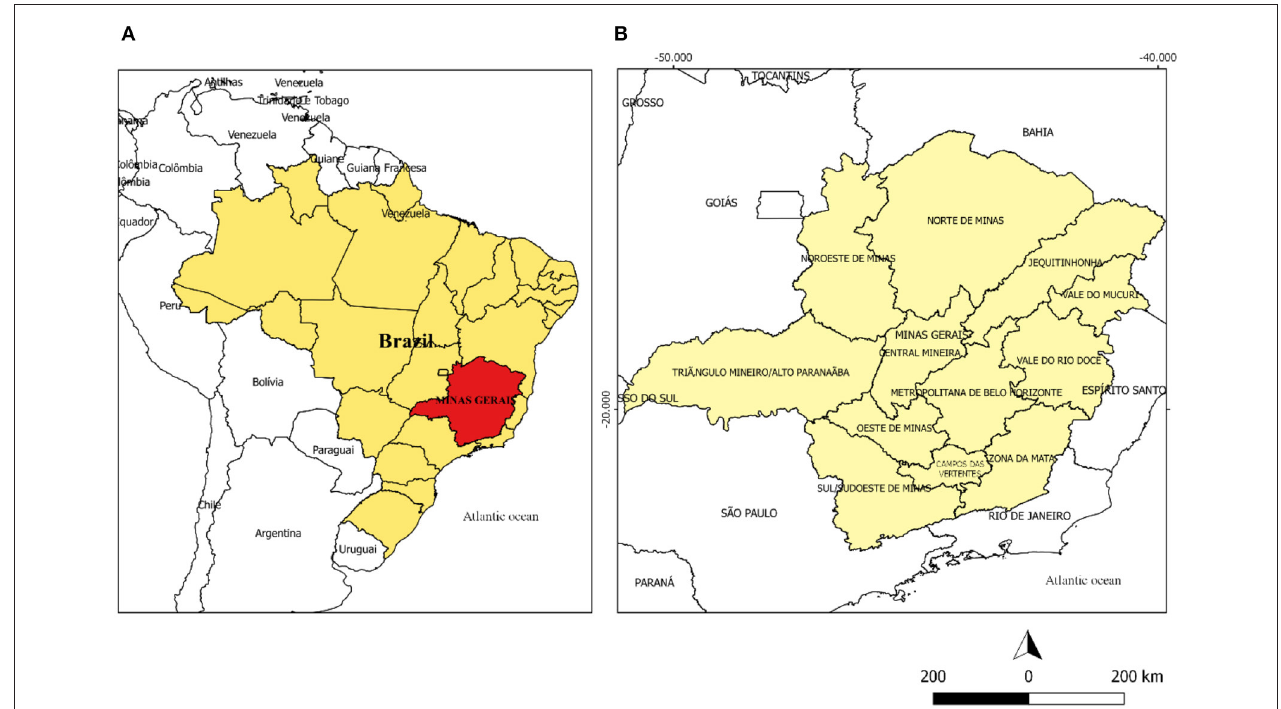
FIGURE 1 | (A) Map of Brazil highlighting the state of Minas Gerais in red. (B) Map of the state of Minas Gerais divided into its mesoregions.